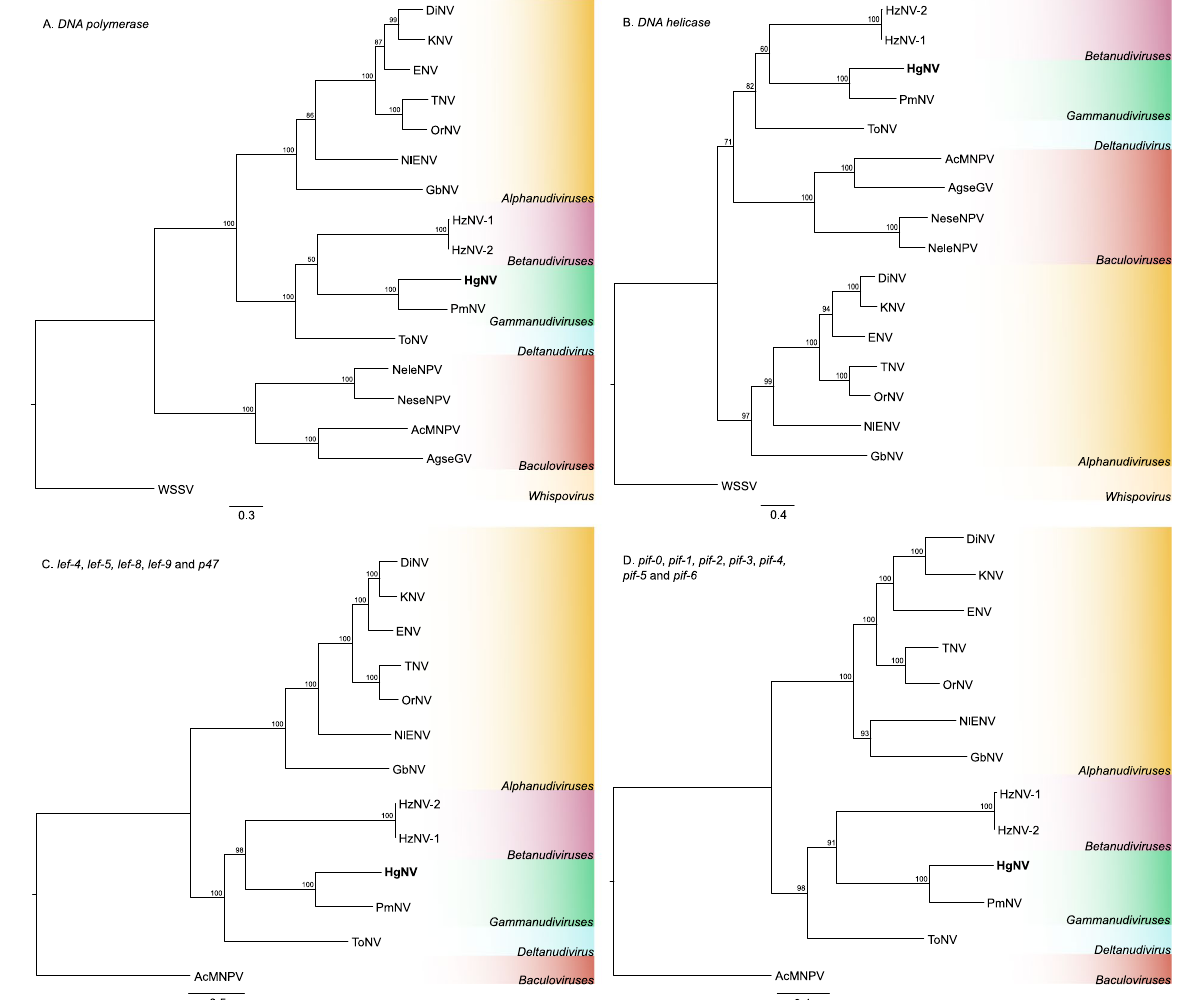
Figure 5. Single and multigene phylogenies of known nudiviruses. Maximum Likelihood analyses of nudivirus phylogeny, including whispovirus and baculovirus outgroups. Node labels indicate bootstrap support (%). ( A ) – Single gene phylogeny of DNA polymerase . ( B ) – Single gene phylogeny of DNA helicase . ( C ) – Multigene phylogeny of late expression factors ( lef-4 , lef-5 , lef-8 , lef-9 and p47 ). ( D ) – Multigene phylogeny of per os infectivity genes ( pif-0 , pif-1 , pif-2 , pif-3 , pif-4 , pif-5 and pif-6 ). DiNV – Drosophila innubila nudivirus, KNV – Kallithea virus (D . melanogaster ), ENV – Esparto virus ( D . melanogaster ), TNV – Tomelloso virus ( D